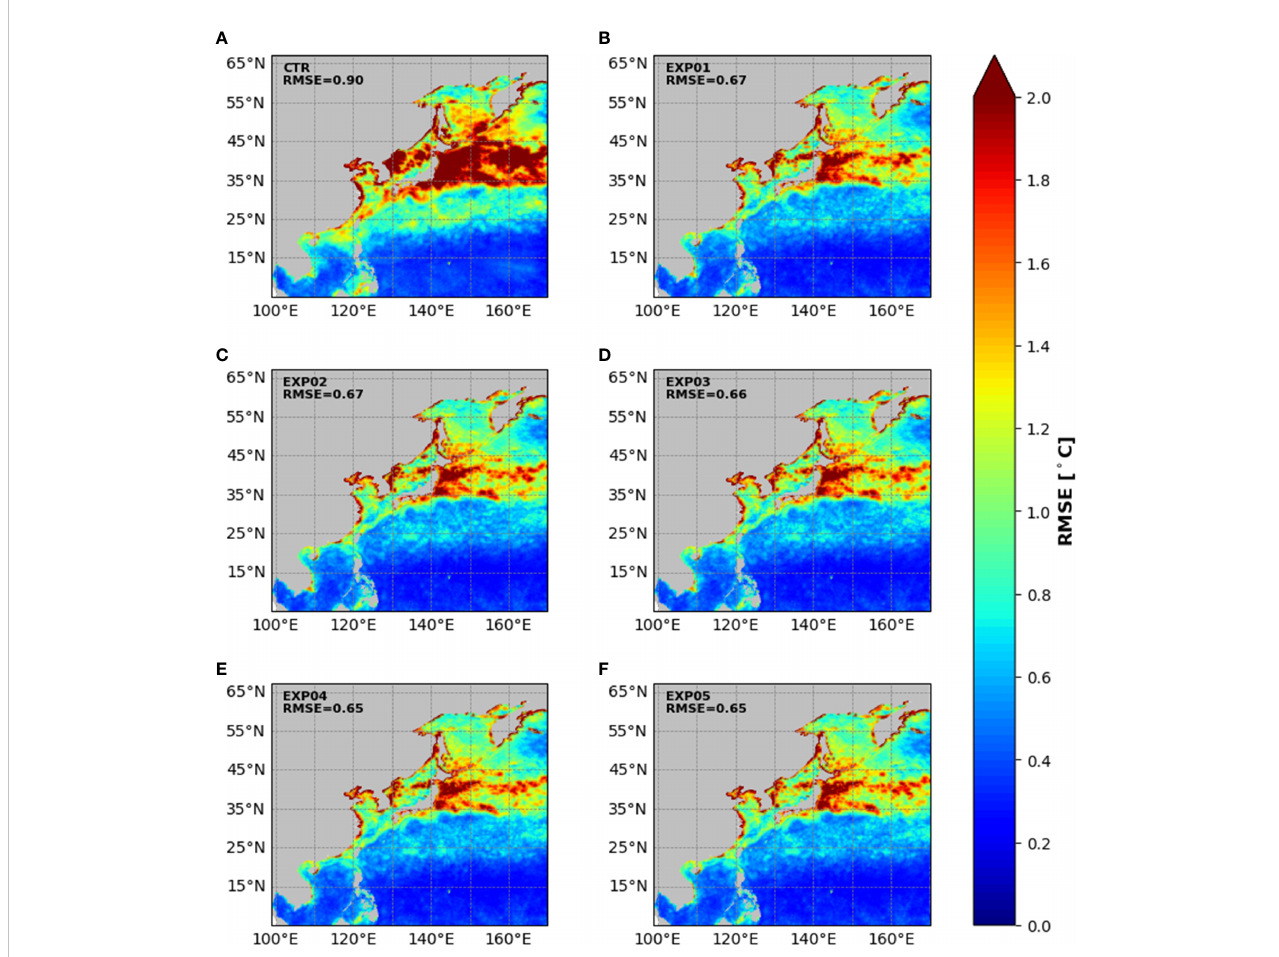
FIGURE 3 Spatial distribution of RMSE for SST with respect to OSTIA SST. Spatial averaged RMSEs of each experiment are shown on each fi gure. (A-F) represent the results of CTR and EXP01-05, respectively. RMSE, root-mean-square error; SST, sea salt temperature; CTR, control; EXP, experiment; OSTIA, Operational Sea Surface Temperature, and Sea Ice